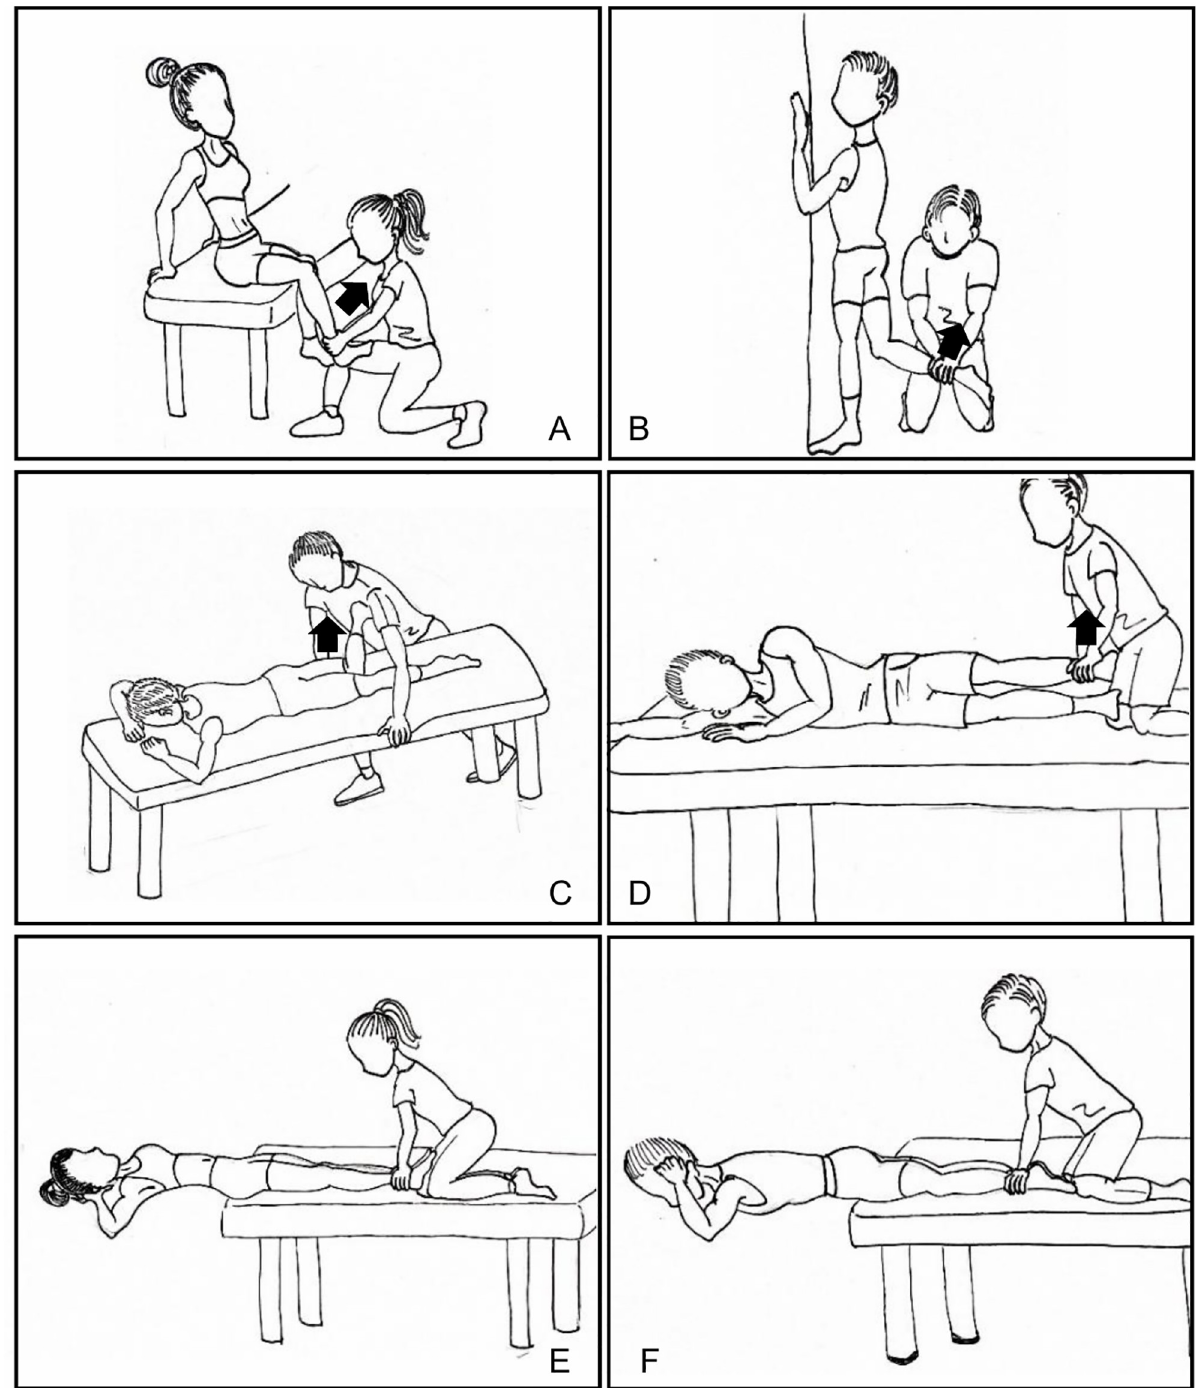
Fig 1. Maximum Voluntary Isometric Contraction (MVIC) tests for six targeting muscles. A: Rectus femoris (knee extension). B: Biceps femoris (knee flexion). C: Gluteus maximus (hip extension). D: Gluteus medius (hip abduction). E: Rectus abdominus (trunk flexion). F: Erector spinae (trunk